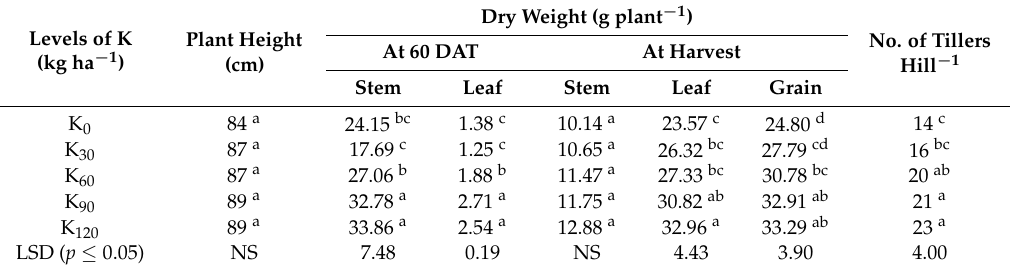
Table 3. Growth attributes of hybrid rice (var. Arize 6444) as influenced by potassium fertilization (means for 2016 and 2017)